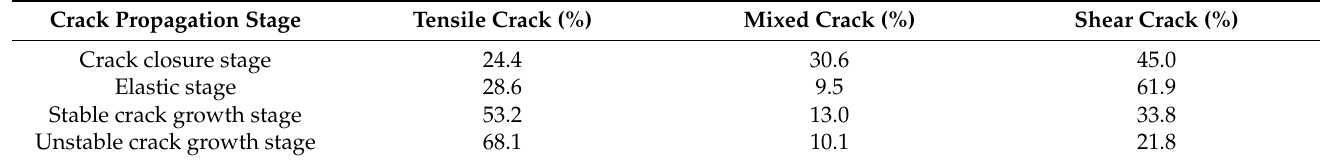
Table 5. Different crack types in the process of rock failure of sample